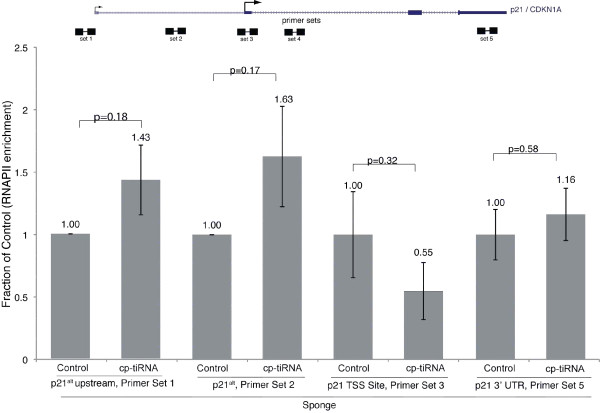
RNA polymerase II (RNAPII) response to the p21 (cyclin-dependent kinase inhibitor 1A gene, also known as CDKN1A) CCCTC-binding factor (CTCF) proximal (cp)-transcription initiation (ti)RNA sponge. Active RNAPII enrichment sites in the p21 (CDKN1A) locus were determined by chromatin immunoprecipitation (ChIP). RNAPII levels are generally unaffected, although a modest increase in RNAPII activity downstream of the p21alt transcription start site was observed.